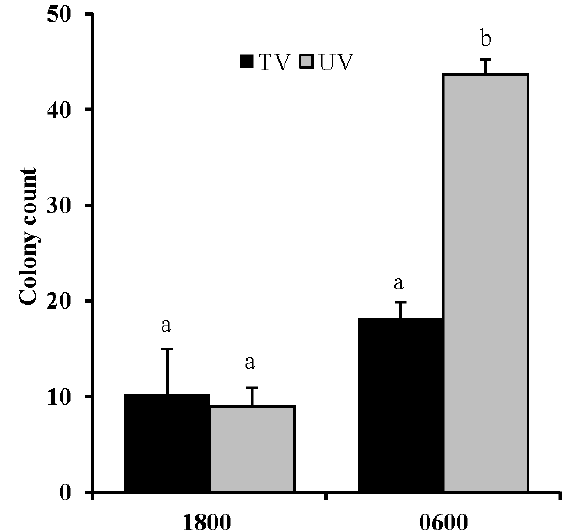
Figure 5. Changes in bacterial count upon nipple attachments in unventilated (UV) and tunnel-ventilated (TV) systems. Values represent the mean±standard error (n = 30). Values with different superscripts ( a,b ) differ significantly (p<0.05).